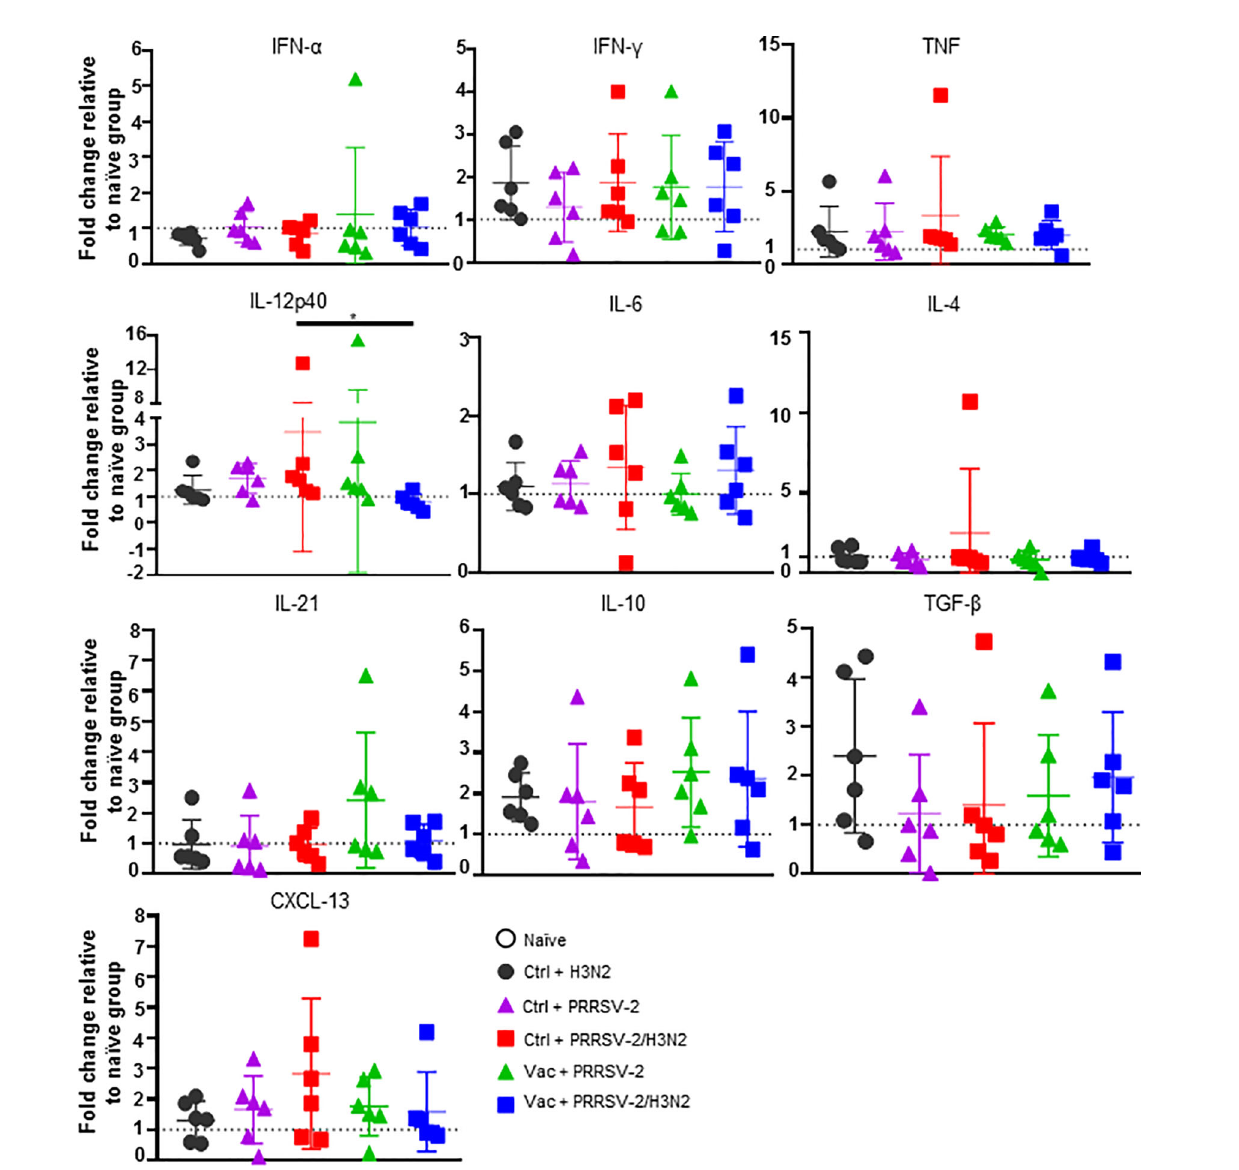
FIGURE 7 | Gene expression in lung tissues. Total RNA was extracted from lung tissue collected at 5 dpc and the relative mRNA expression of IFN- a , IFN- g , TNF, IL-12p40, IL-4, IL-6, IL-21, IL-10, TGF- b and CXCL-13 was assessed by qRT-PCR. Fold changes are shown over naïve group (dash line) after normalization with GAPDH and RPS24 genes. Individual pig values and the group mean ± SD are displayed (n = 5-6 per group). Comparisons were made using Kruskal-Wallis test and asterisks indicate signi fi cant differences (*p <